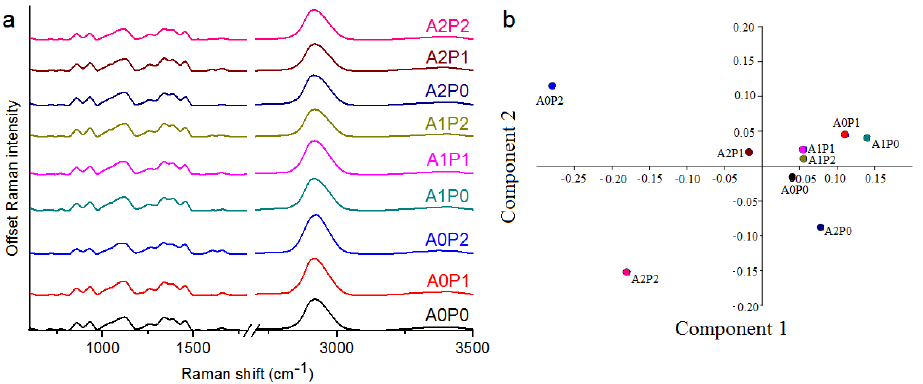
Figure 14. ( a ) FT-Raman spectra of oat grains (2018); ( b ) PCA analysis of FT-Raman spectra of oat grains in 800–1800 cm − 1 where A0P0—no fertilizer, no magnetostimulation; A0P1—no fertilizer, short magnetostimulation; A0P2—no fertilizer, longer magnetostimulation; A1P0—average dose of algae, no magnetostimulation; A1P1—average dose of algae, short magnetostimulation; A1P2—average dose of algae, longer magnetostimulation; A2P0—maximum dose of algae, no magnetostimulation; A2P1—maximum dose of algae fertilizer, short magnetostimulation; A2P2—maximum dose of algae, longer